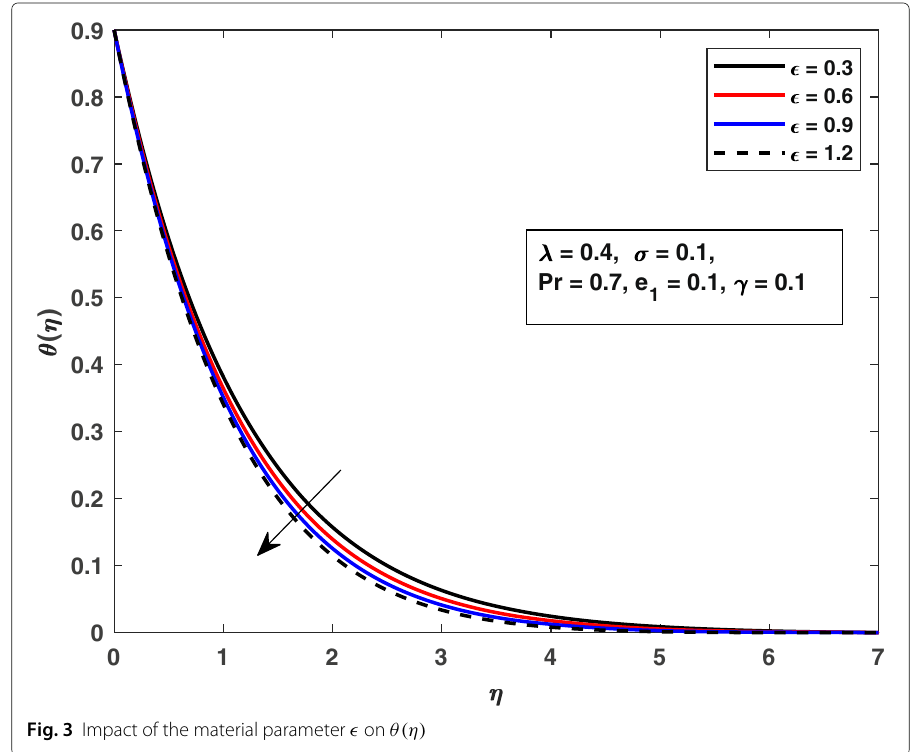
Fig. 3 Impact of the material parameter (cid:10) on θ(η)